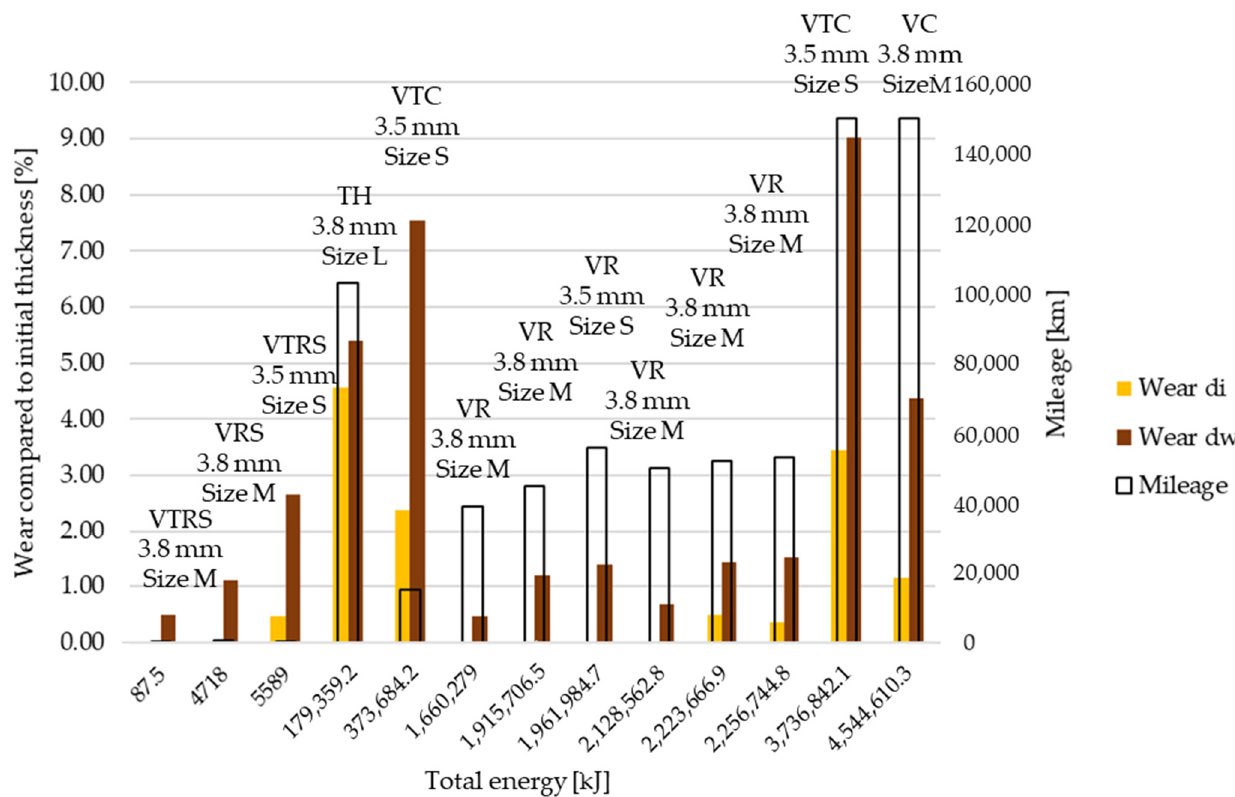
Figure A1. Relative wear values on inner (di) and working (dw) diameter with mileage along Joule scale.